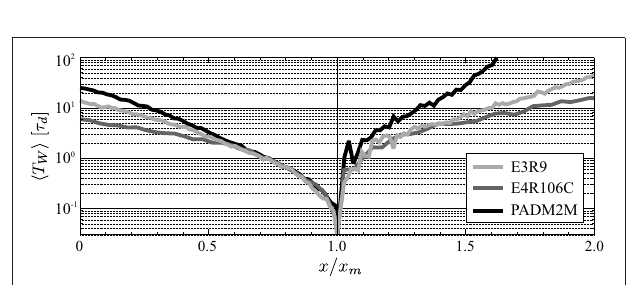
estimated standard errors in each bin (mostly smaller than the symbol sizes themselves).